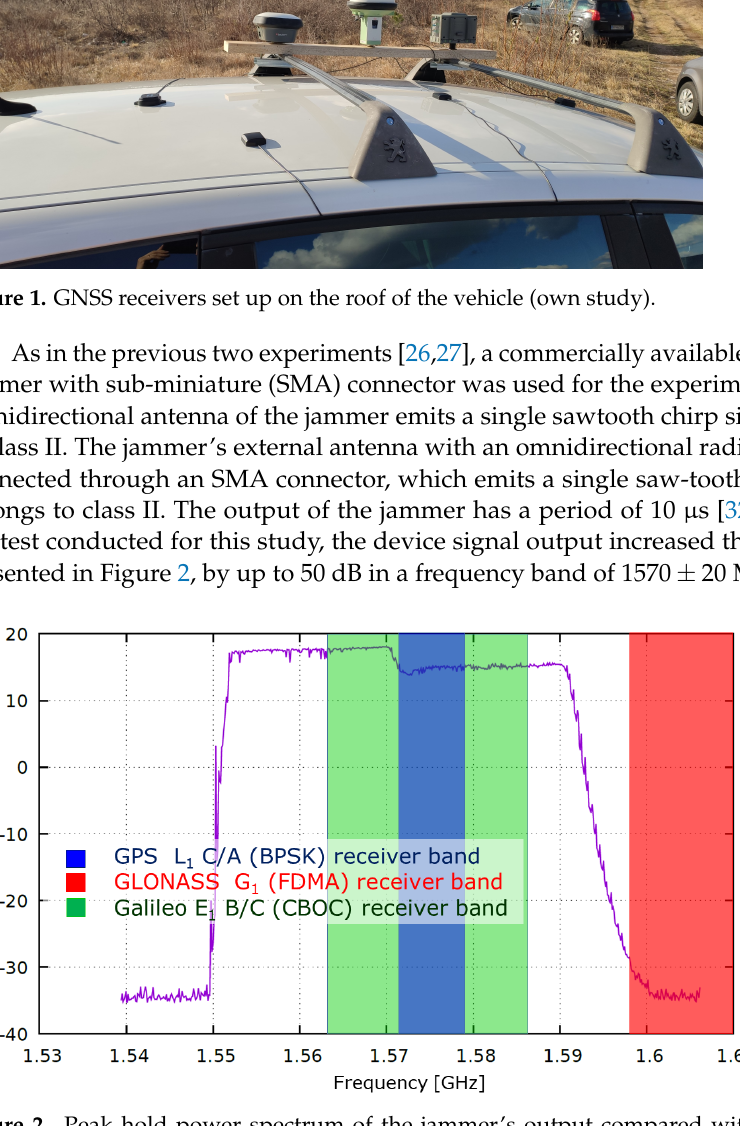
Figure 2. Peak hold power spectrum of the jammer’s output compared with typical front-end bandwidths of GNSS receivers (own